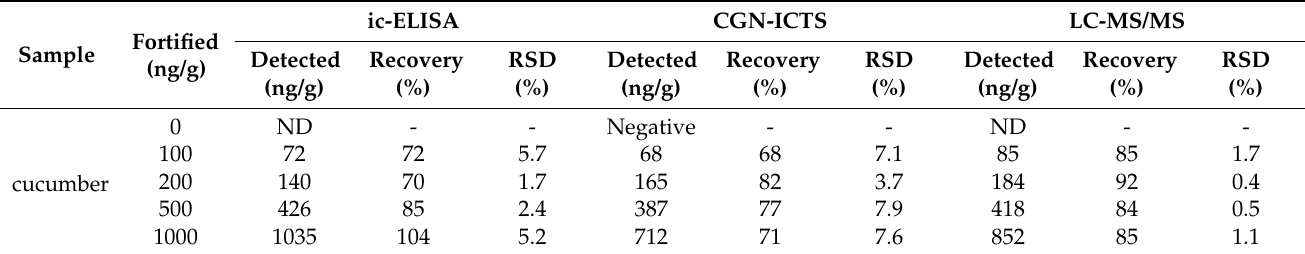
Table 4. Average recoveries of CPPU in cucumber samples measured by ic-ELISA, CGN-ICTS, and LC-MS/MS.